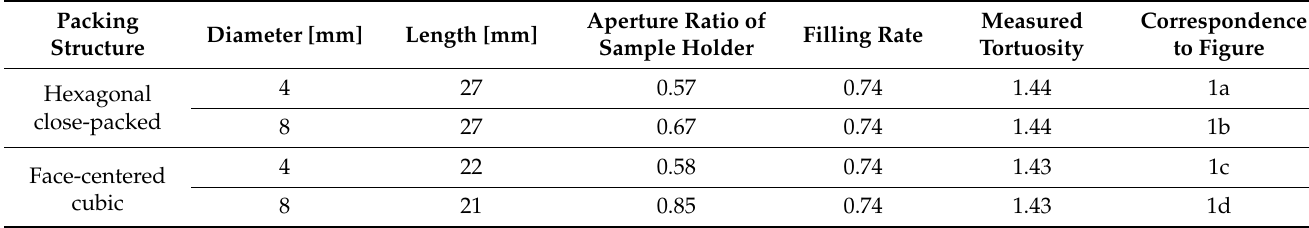
Table 1. Properties of test